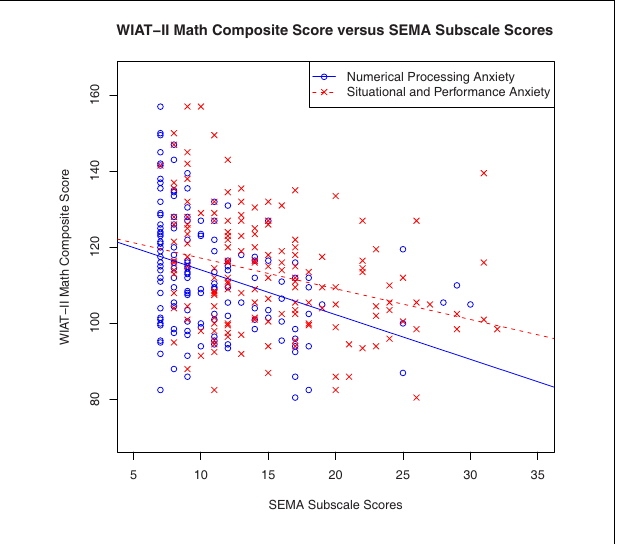
FIGURE 3 | Math achievement (WIAT-II Math Composite) was significantly correlated with both SEMA